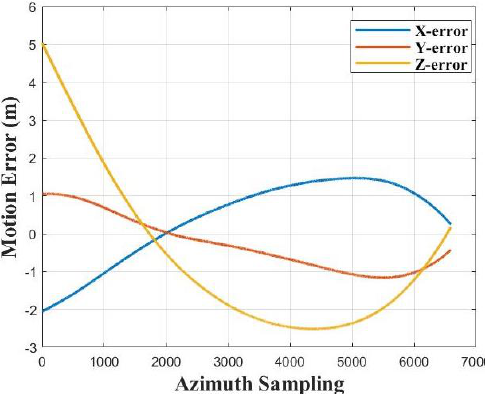
Figure 7. Motion displacements in the Cartesian coordinate system.